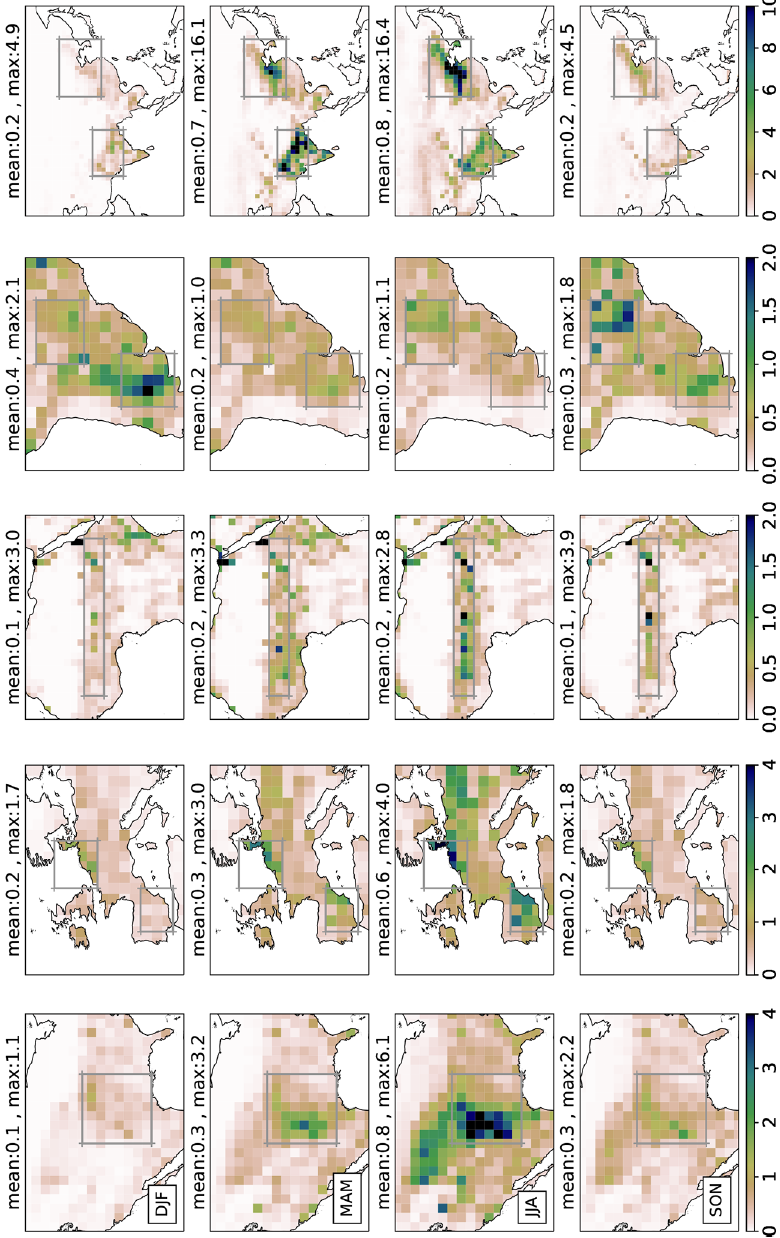
Figure 5. Regional seasonal agricultural ammonia emissions averaged over the 2005–2015 period (gNm − 2 yr − 1 ) simulated by CAMEO. Boxes delimit the regions used in the analysis comparing CAMEO emissions with IASI inv (Sect. 3.5). Note that the scales are different for each